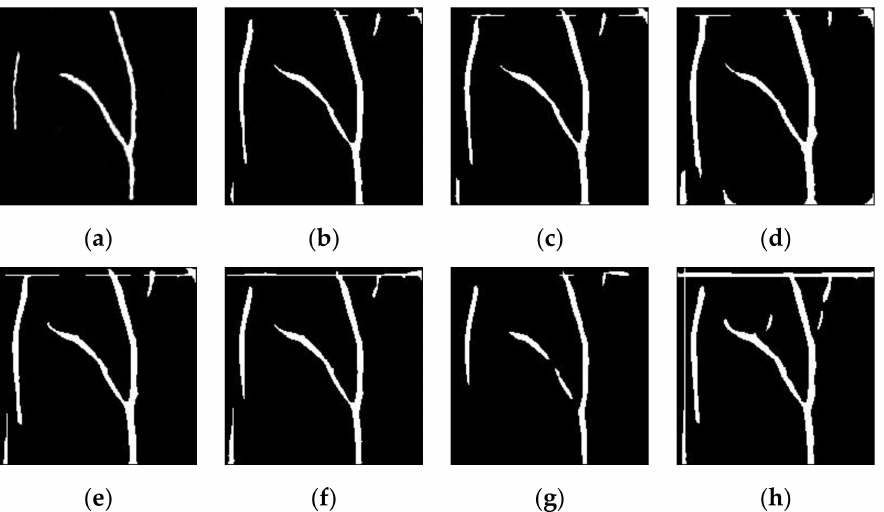
Figure 11. Sample results of vein detection for various image enhancement techniques on the SUAS database: ( a ) truth image; ( b ) improved weighted average fusion CLAHE + FAG(proposed); ( c ) weighted average fusion CLAHE + FAG(proposed); ( d ) FAG(proposed); ( e ) AGC; ( f ) FHH; ( g ) CLAHE; ( h ) without